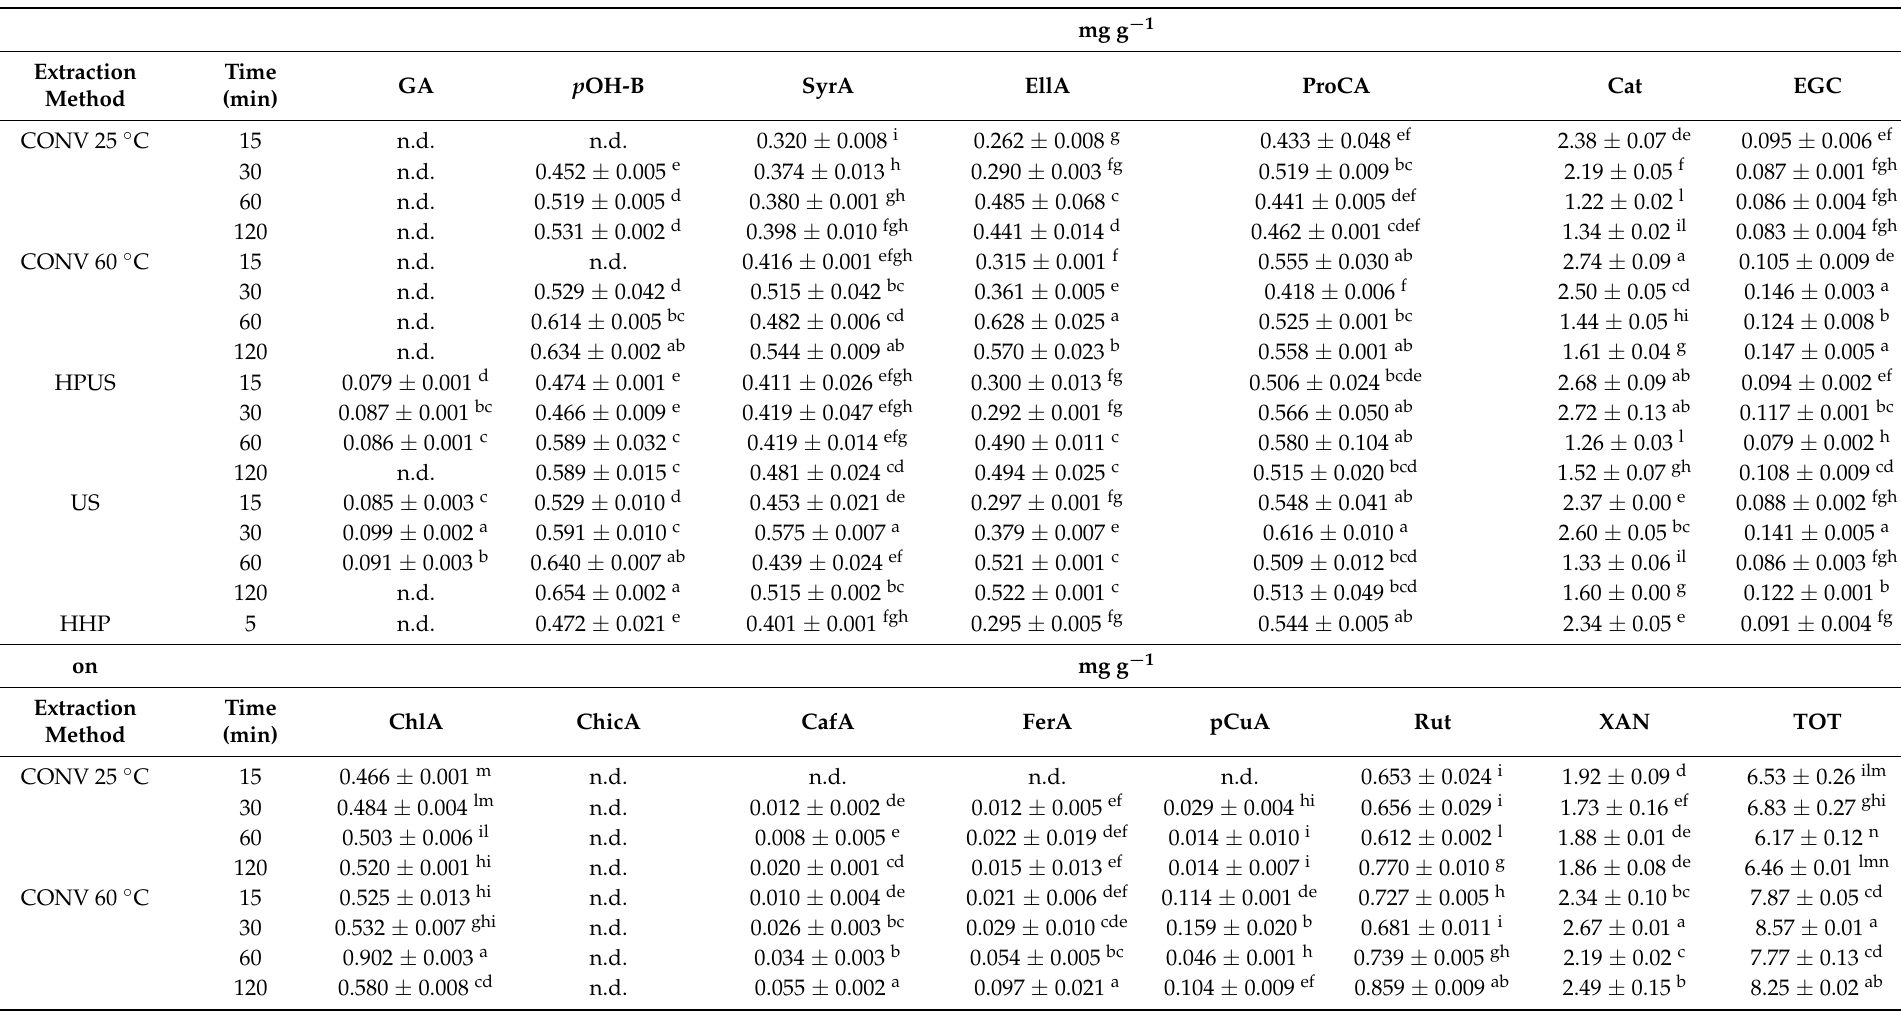
Table 1. Phenolic composition (mg g − 1 ) of different hop extracts determined by high-performance liquid chromatography (mean ± standard